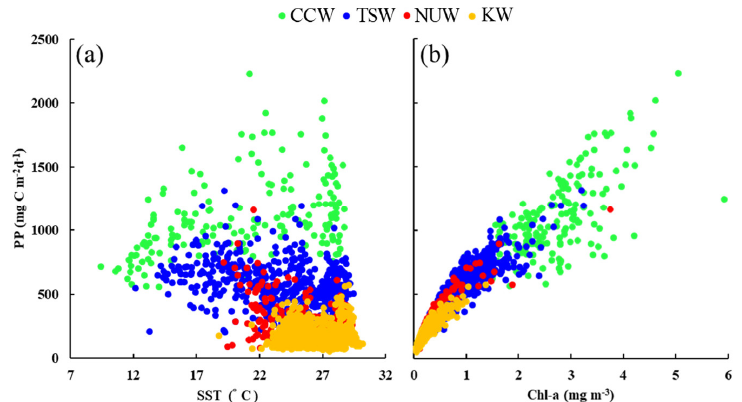
Figure 6. Relationship between the monthly mean of ( a ) AVHRR SST and VPGM PP A , and ( b ) MODIS Aqua Chl-a and VPGM PP A for each 1 °C gridded area in the four subareas of CCW (green circles), TSW (blue circles), NUW (red circles), and KW (yellow circles) from 2009 to 2013. The comparison of in situ data and model data for each subarea is presented in Table 3. The PP A had significant correlations with in situ PP in the TSW (r 2 = 0.26), NUW (r 2 = 0.37) and KW (r 2 = 0.14).